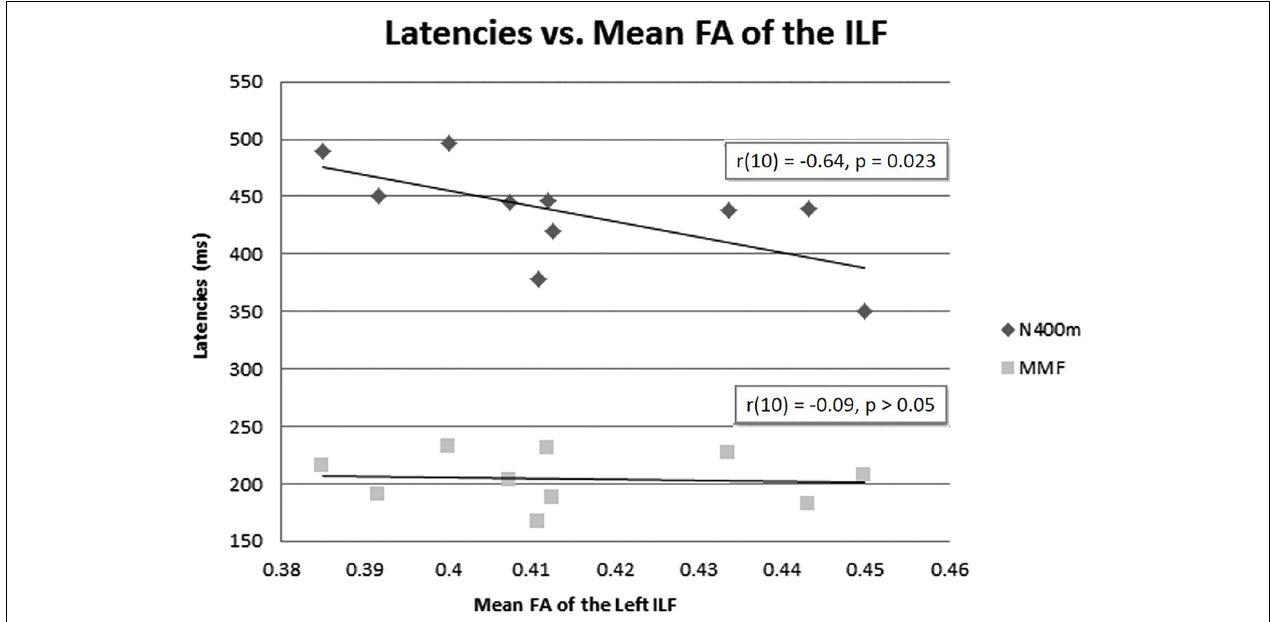
FIGURE 6 | N400m and MMF latencies and mean FA of the left ILF. A negative correlation between N400m peak latency and mean FA of the left ILF has been identified [ r (10) = –0.64, p = 0.023, R 2 = 0.41]. No correlation was found between MMF and mean FA of the left ILF or between N400m latency and mean FA of the right